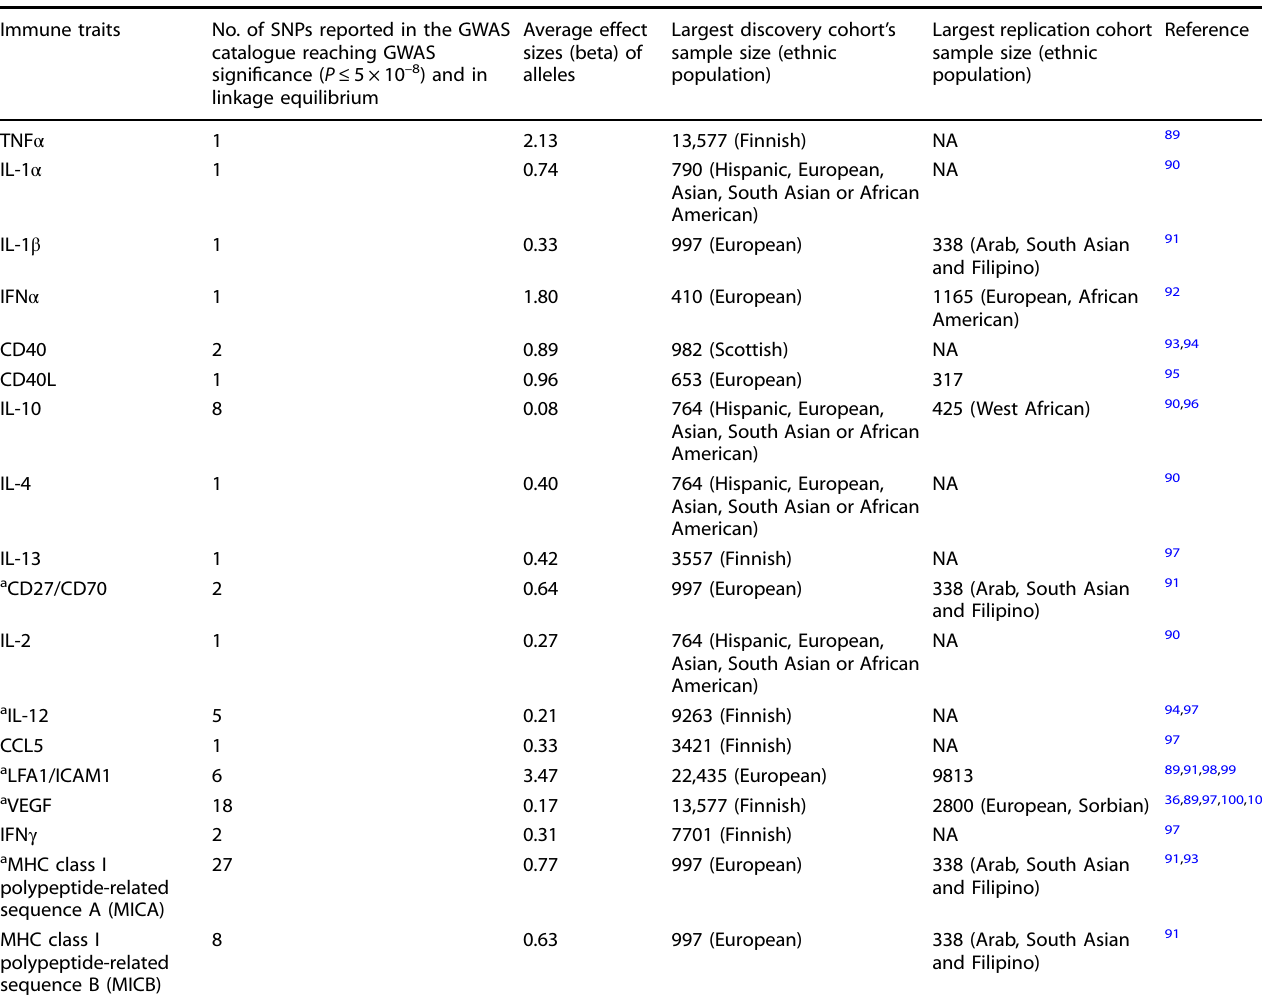
Table 2. Genetic variants associated with immune-modulatory traits in the cancer immunity cycle. Immune